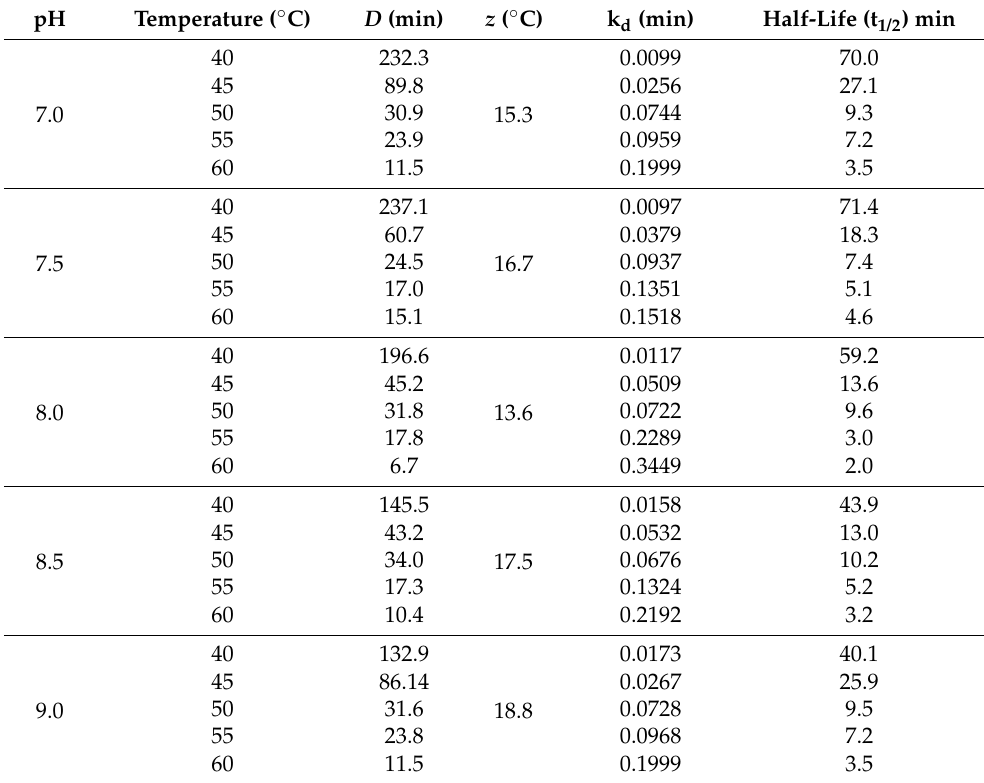
Table 3. Values of parameters D , z , k d , and half-life (t 1/2 ) obtained by the thermal denaturation of purified protease from Bacillus sp.